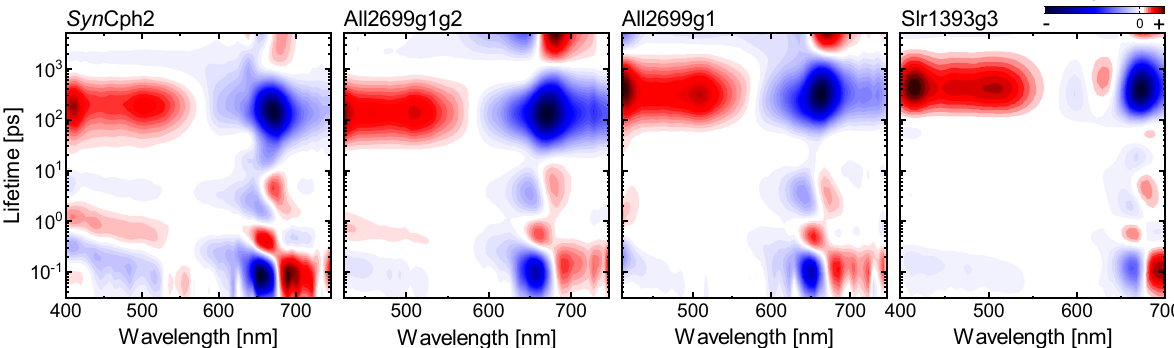
Figure 4. Lifetime density maps of several longer lived phytochromes with similar kinetics including Syn Cph2, All2699g1g2 [50], All2699g1 [53] and Slr1393g3 [41,59].